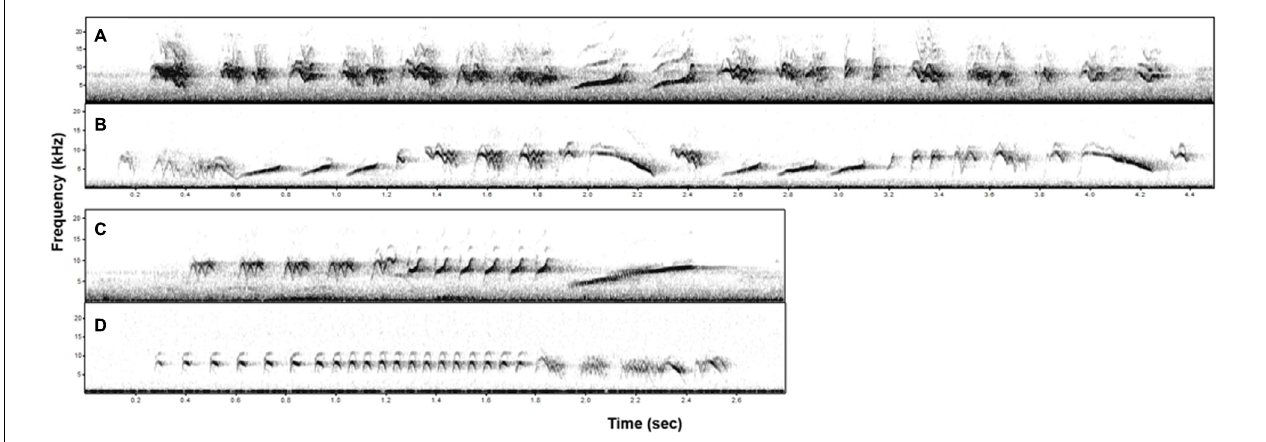
FIGURE 2 | Spectrograms of four bananaquit songs differing in levels of elaboration, i.e., in the number of different syllable types. More (A,B) and less (C,D) elaborate songs occur both in the most geographically distant